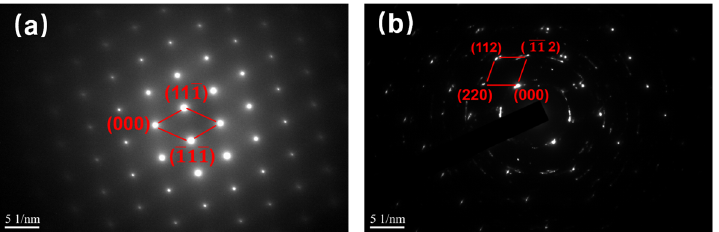
Figure 4. The electron diffraction pattern (TEM) of Z3CN20-09M cast stainless steel: ( a ) matrix; ( b ) sharp-angled grains.